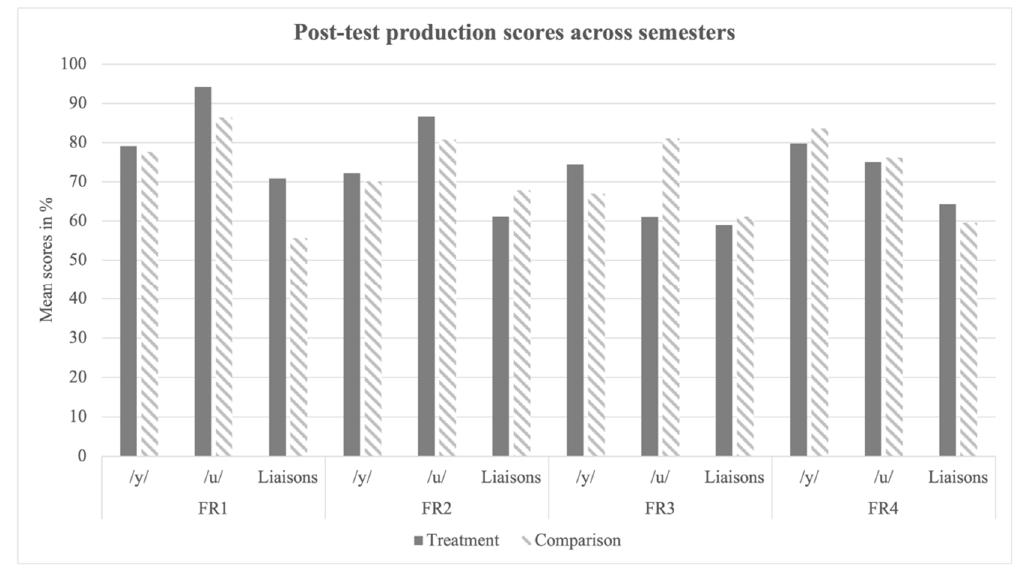
Figure 2 represent the post-test mean scores of the Treatment group and the Comparison group across phonological features and semesters.